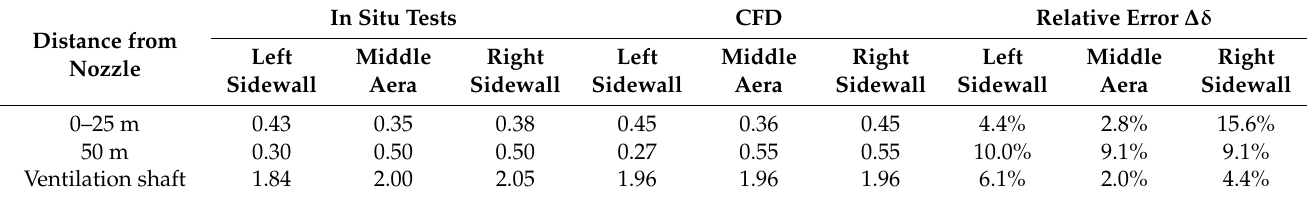
Table 5. Results of air velocity measurements during in situ tests and from the CFD calculations.